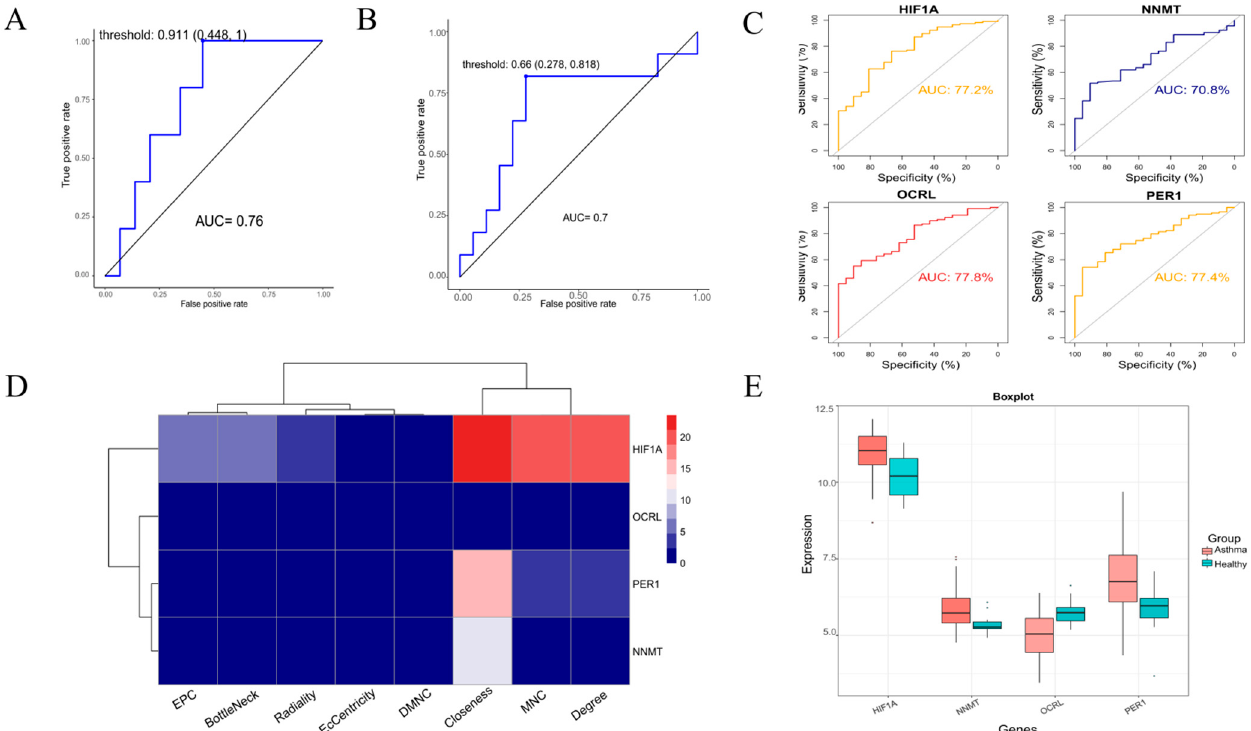
Figure 3. Verify model feasibility and visualize gene expression. ( A ) Model evaluation based on training set GSE76262. ( B ) Model evaluation based on test set GSE4302. ( C ) ROC curves of HIF1A, NNMT, OCRL, and PER1 in datasets GSE76262. ( D ) The 8 scoring methods of PPI to score HIF1A, NNMT, OCRL, and PER1. ( E ) The expression of HIF1A, NNMT, OCRL, and PER1 in the training dataset GSE76262.